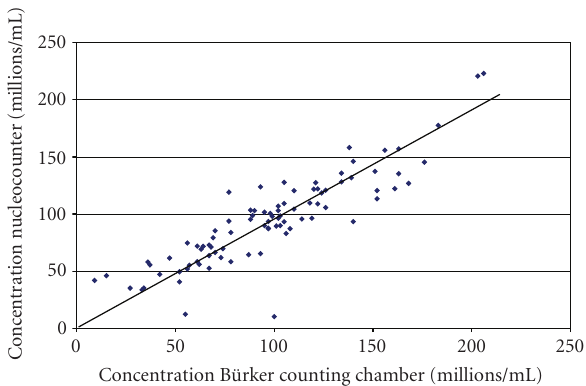
Figure 4: Relationship between sperm concentration measured with the Nucleocounter SP-100 and with the B¨urker counting chamber ( n = 89).